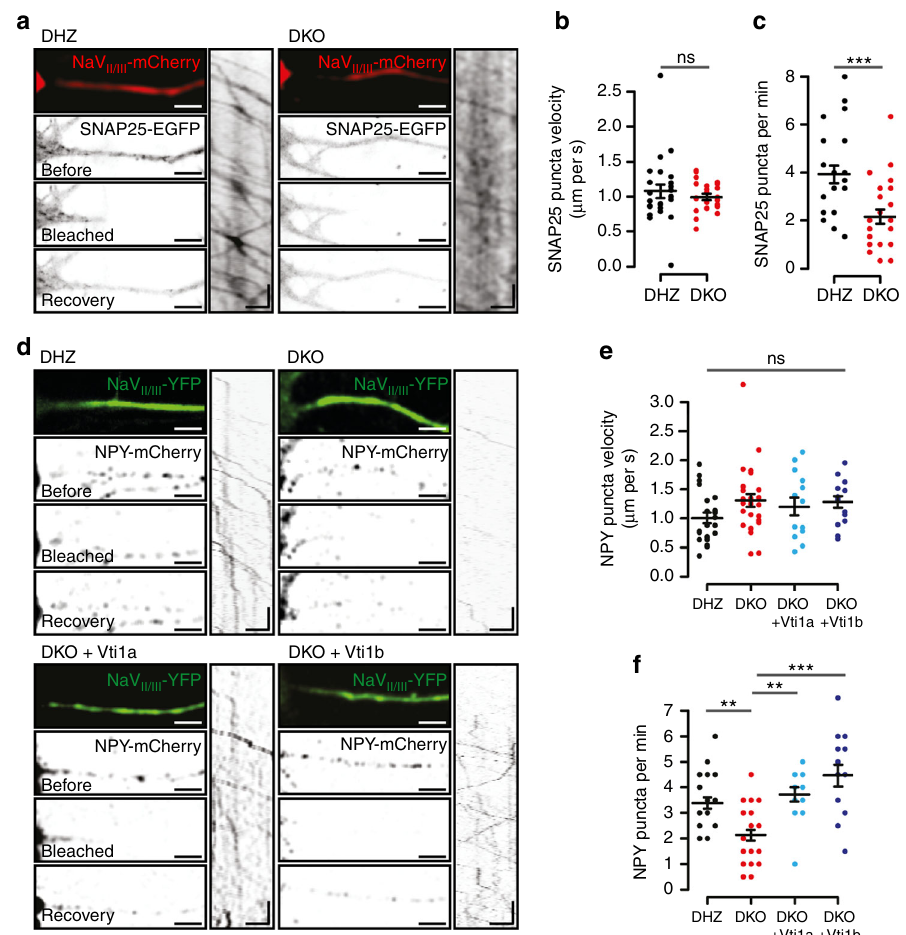
Fig. 5 Reduced in fl ux of SNAP25 and DCV cargo into axons in Vti1a/b-de fi cient neurons. a Representative examples of DIV-5 neurons, in mass cultures, expressing SNAP25-EGFP and the axonal-initial-segment (AIS) marker NaV II/III -mCherry before, after photobleaching and three minutes after photobleaching. Kymographs show SNAP25-EGFP puncta in the AIS photobleached segment. b No differences in SNAP25 puncta velocity in the AIS (DHZ: 1.08 ± 0.10, n = 24; DKO: 0.99 ± 0.04 µ m/s, n = 24; Mann – Whitney). c Less SNAP25 puncta enter the AIS in DKO neurons (DHZ: 3.93 ± 0.37, n =